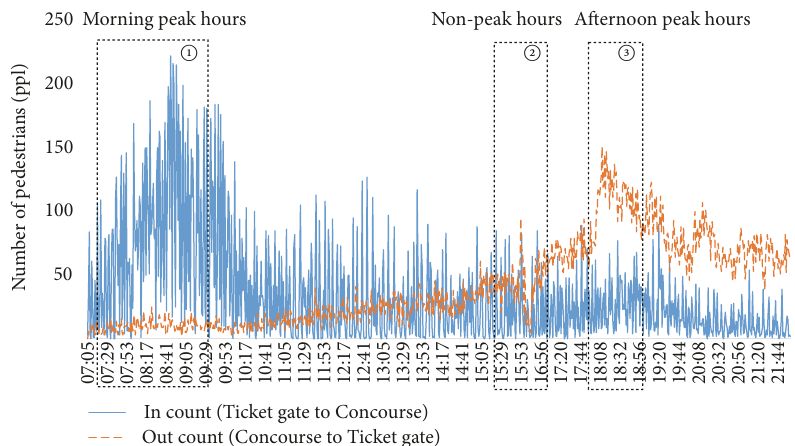
Figure 3: Pedestrian counts from ticket gate to concourse by time of day on July 12, 2017, in Samseong station. The dotted boxes designate the morning peak hours (1), nonpeak hours (2), and afternoon peak hours